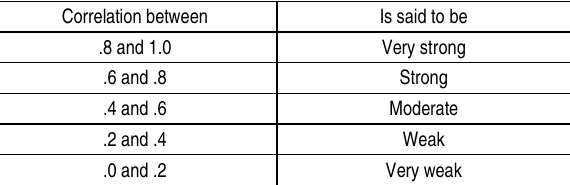
Table 1. Interpretation of the correlation coefficient